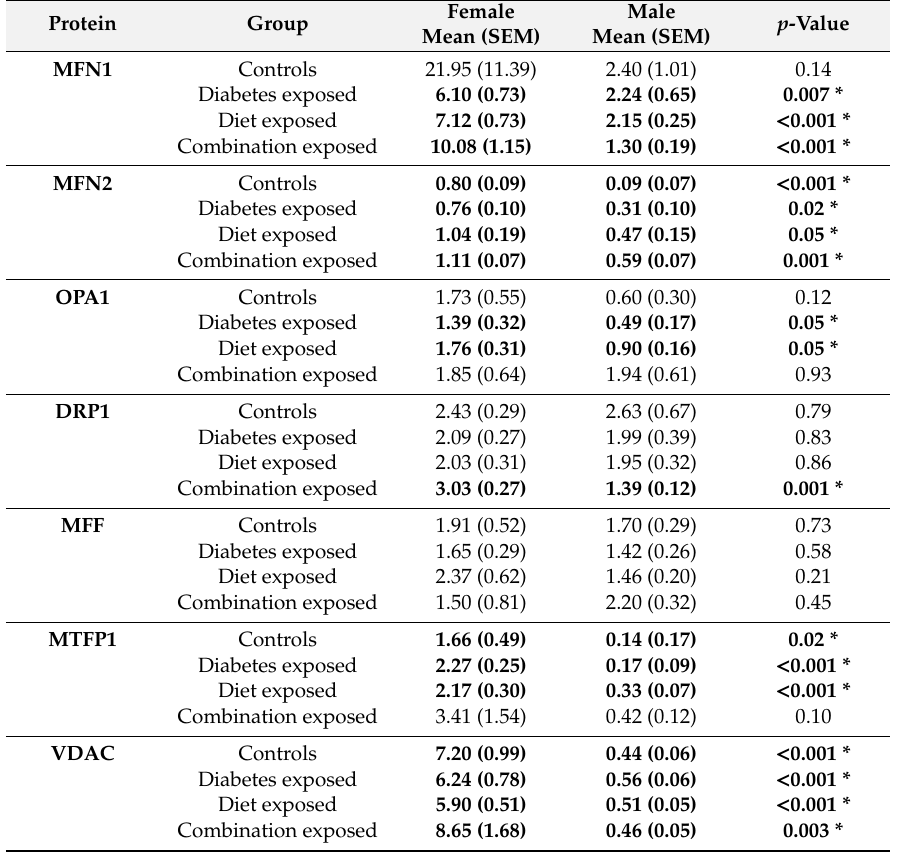
Table 2. Sex-specific di ff erences in expression of proteins involved in mitochondrial